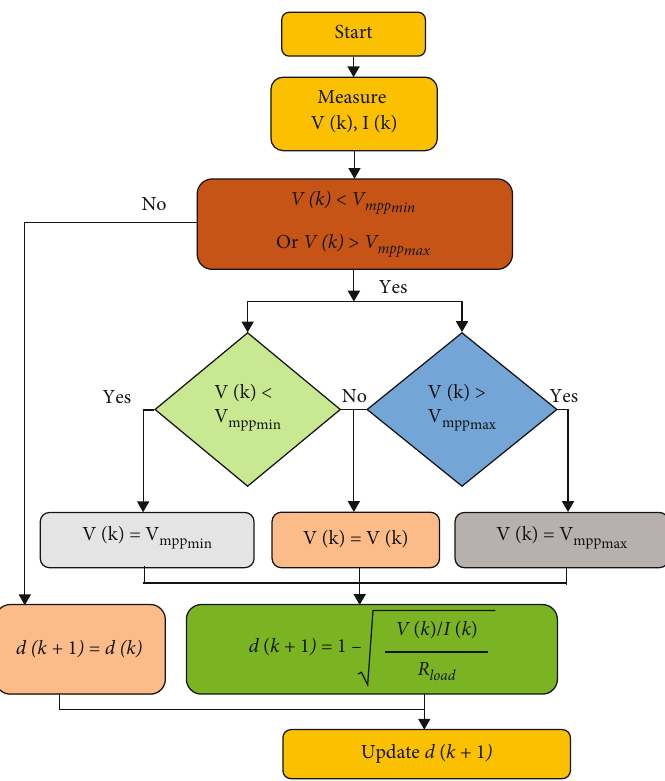
Figure 6: Flowchart of the suggested MPPT